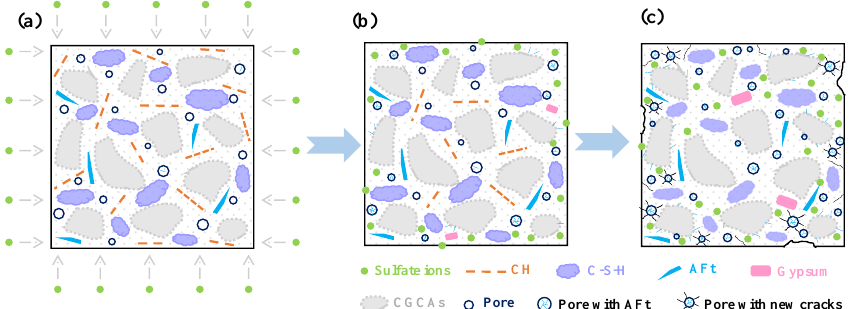
Figure 12. Schematic diagram of sulfate corrosion model: ( a ) ingress of sulfate ions; ( b ) gradual penetration of sulfate ions; ( c ) damage of